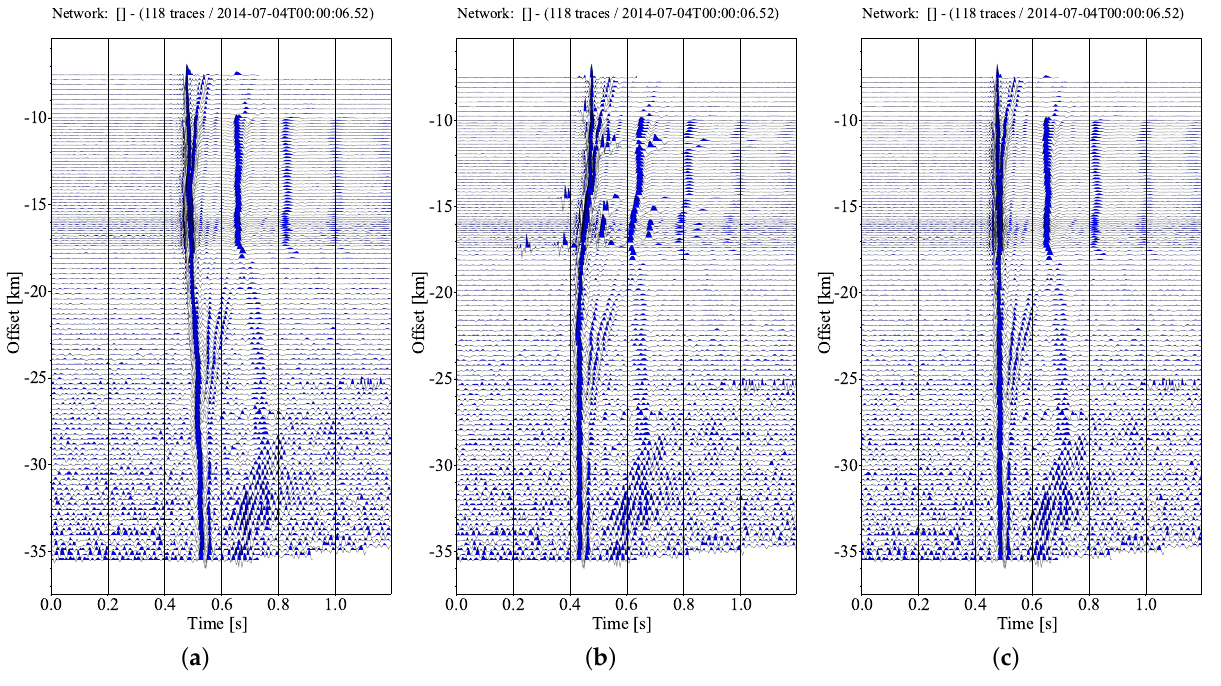
Figure 7. Seismic phase Pw alignment corrected by moveouts: ( a ) base time delay Lag 1 obtained by measurement mode 2; ( b ) Lag 2 estimated by MCCC; and ( c ) Lag 3 estimated by improved MCCC ( q m =